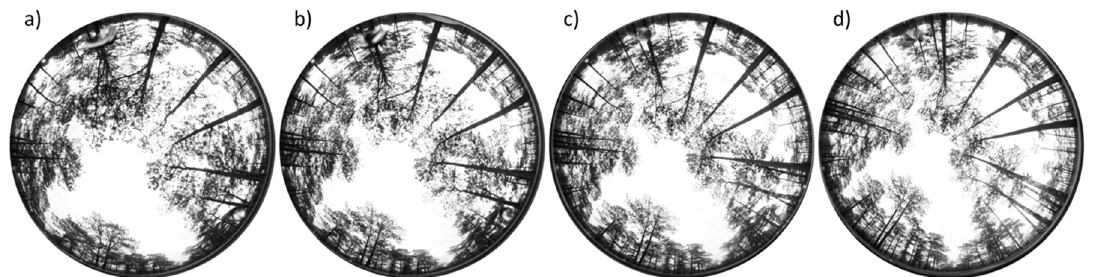
Figure 2. Example of a vertical stack of hemispherical photographs acquired at Transect 2 using four height thresholds, where ( a ) corresponds to 12 m aboveground, ( b ) corresponds to 8 m aboveground, ( c ) corresponds to 4 m aboveground, and ( d ) corresponds to 1.4 m aboveground.